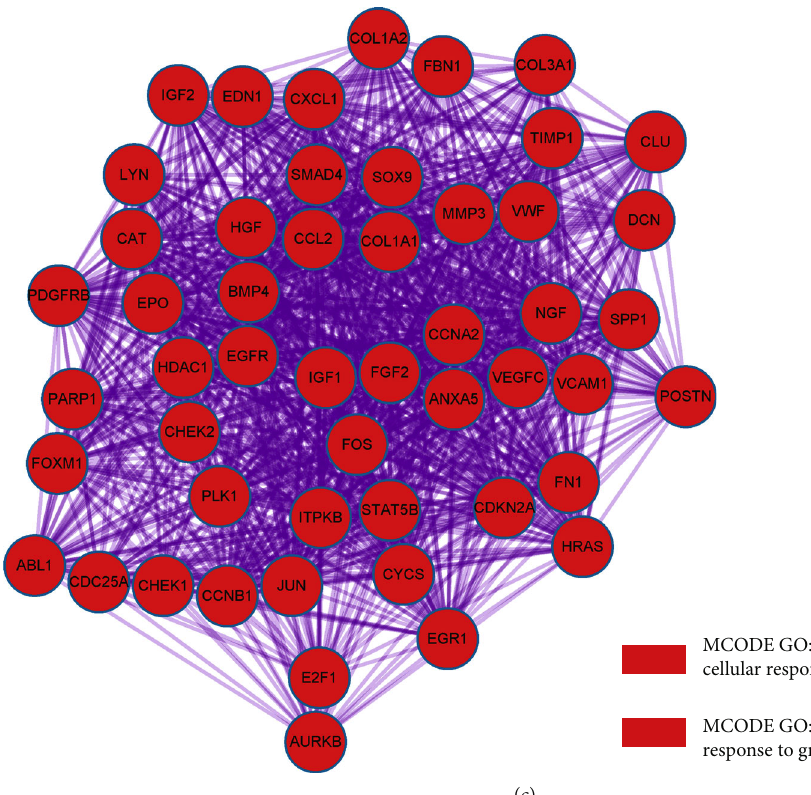
Figure 3: PPI network construction. (a) A PPI network among the 578 DE-ARGs. (b) In the PPI network, the top 60 genes with the most neighboring nodes were displayed. (c) The fi rst MCODE